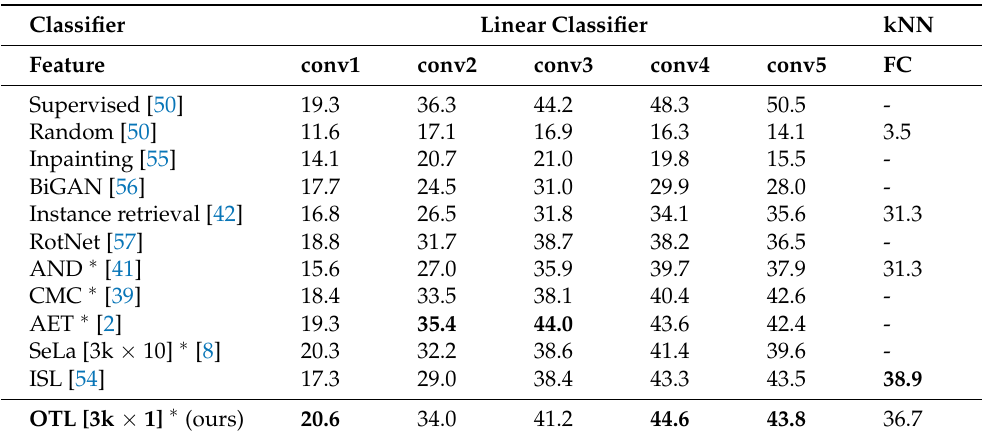
Table 3. Evaluation on ImageNet. “ ∗ ” denotes training on larger AlexNet.”3k × 10/1” denotes 3000 clusters and 10/1 heads (10/1 fully connected layers attached at the end of the architecture). The best results are highlighted by the bold.